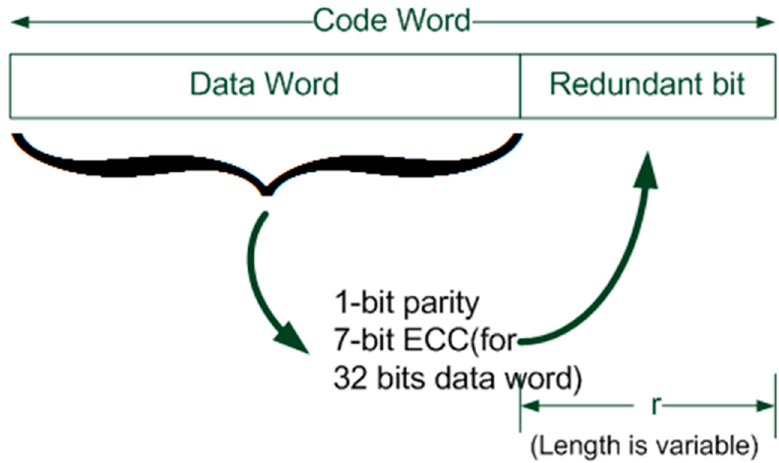
Figure 4. Length of redundant bits depends on the content of data word .